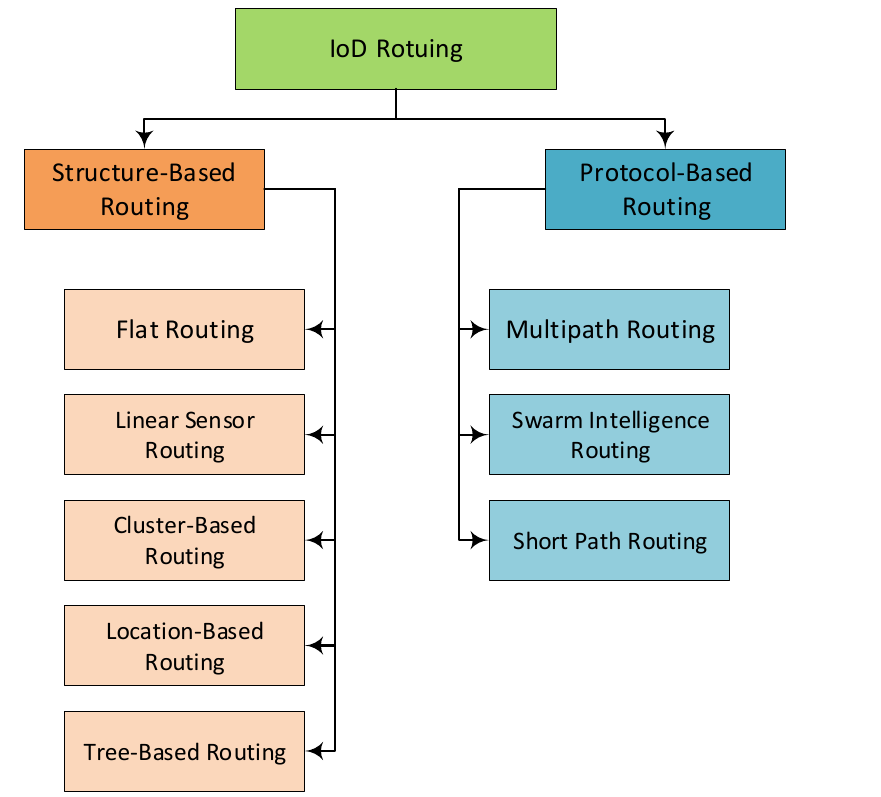
Figure 9. Summary of IoD routing protocols. Table 3. Summary of routing techniques and